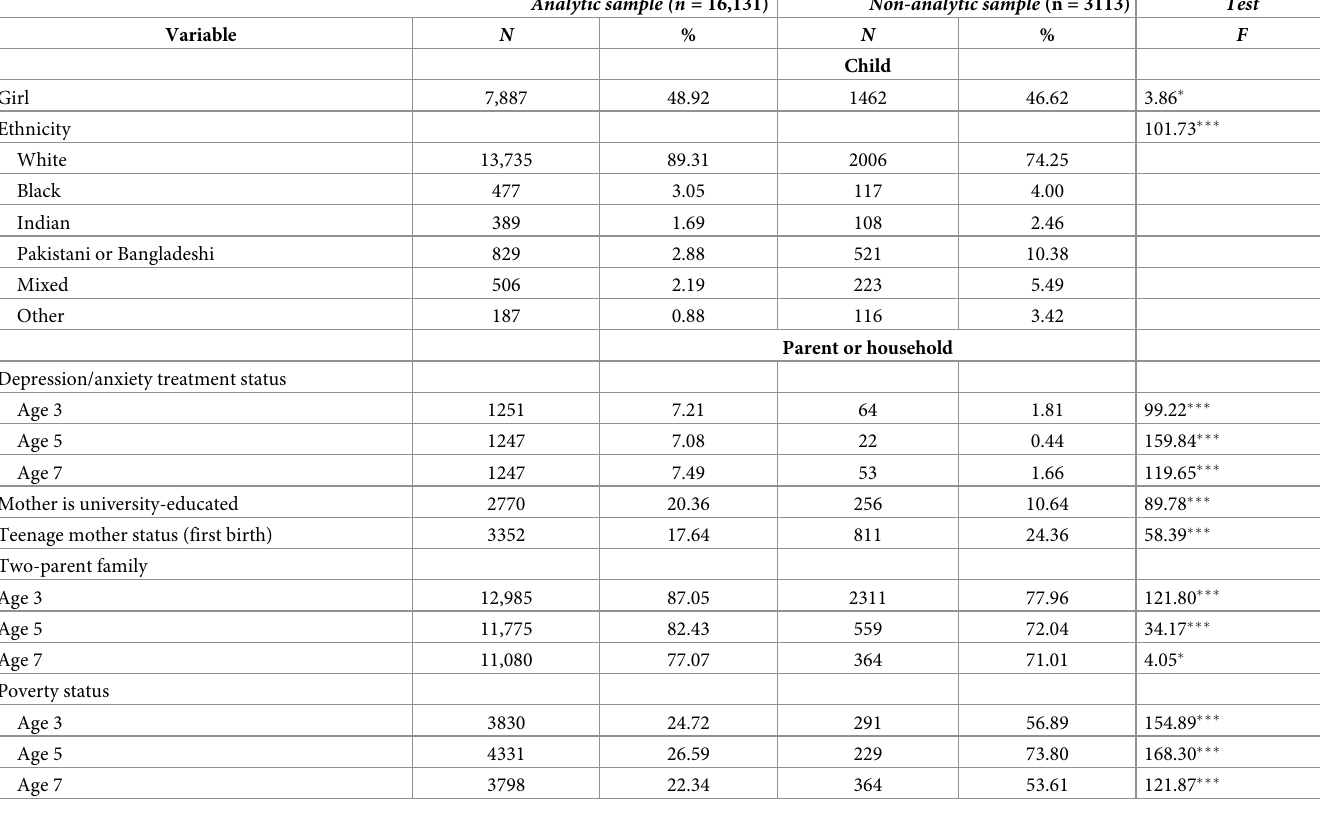
Table 1. Descriptives of categorical study variables in the analytic and non-analytic